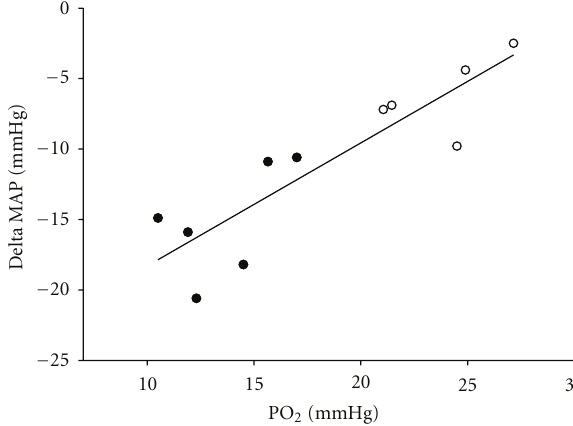
Figure 7: Although blood pressure is the same in the normally grown and the IUGR fetus, the drop in blood pressure in response to an α adrenergic antagonist, phentolamine, is related to fetal arterial PO 2 in control (open circles) and PR (closed circles) fetal sheep ( y = 0 . 87 × − 27 . 01, r 2 = 0 . 78, P = 0 . 003) [5,